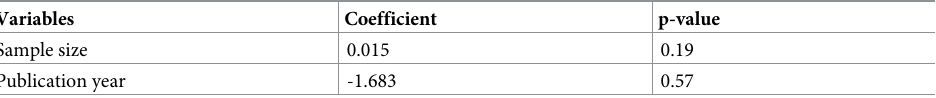
Table 2. Factor, related to the heterogeneity of adolescent girls’ anemia in the current meta-analysis (univariate meta-regression model).